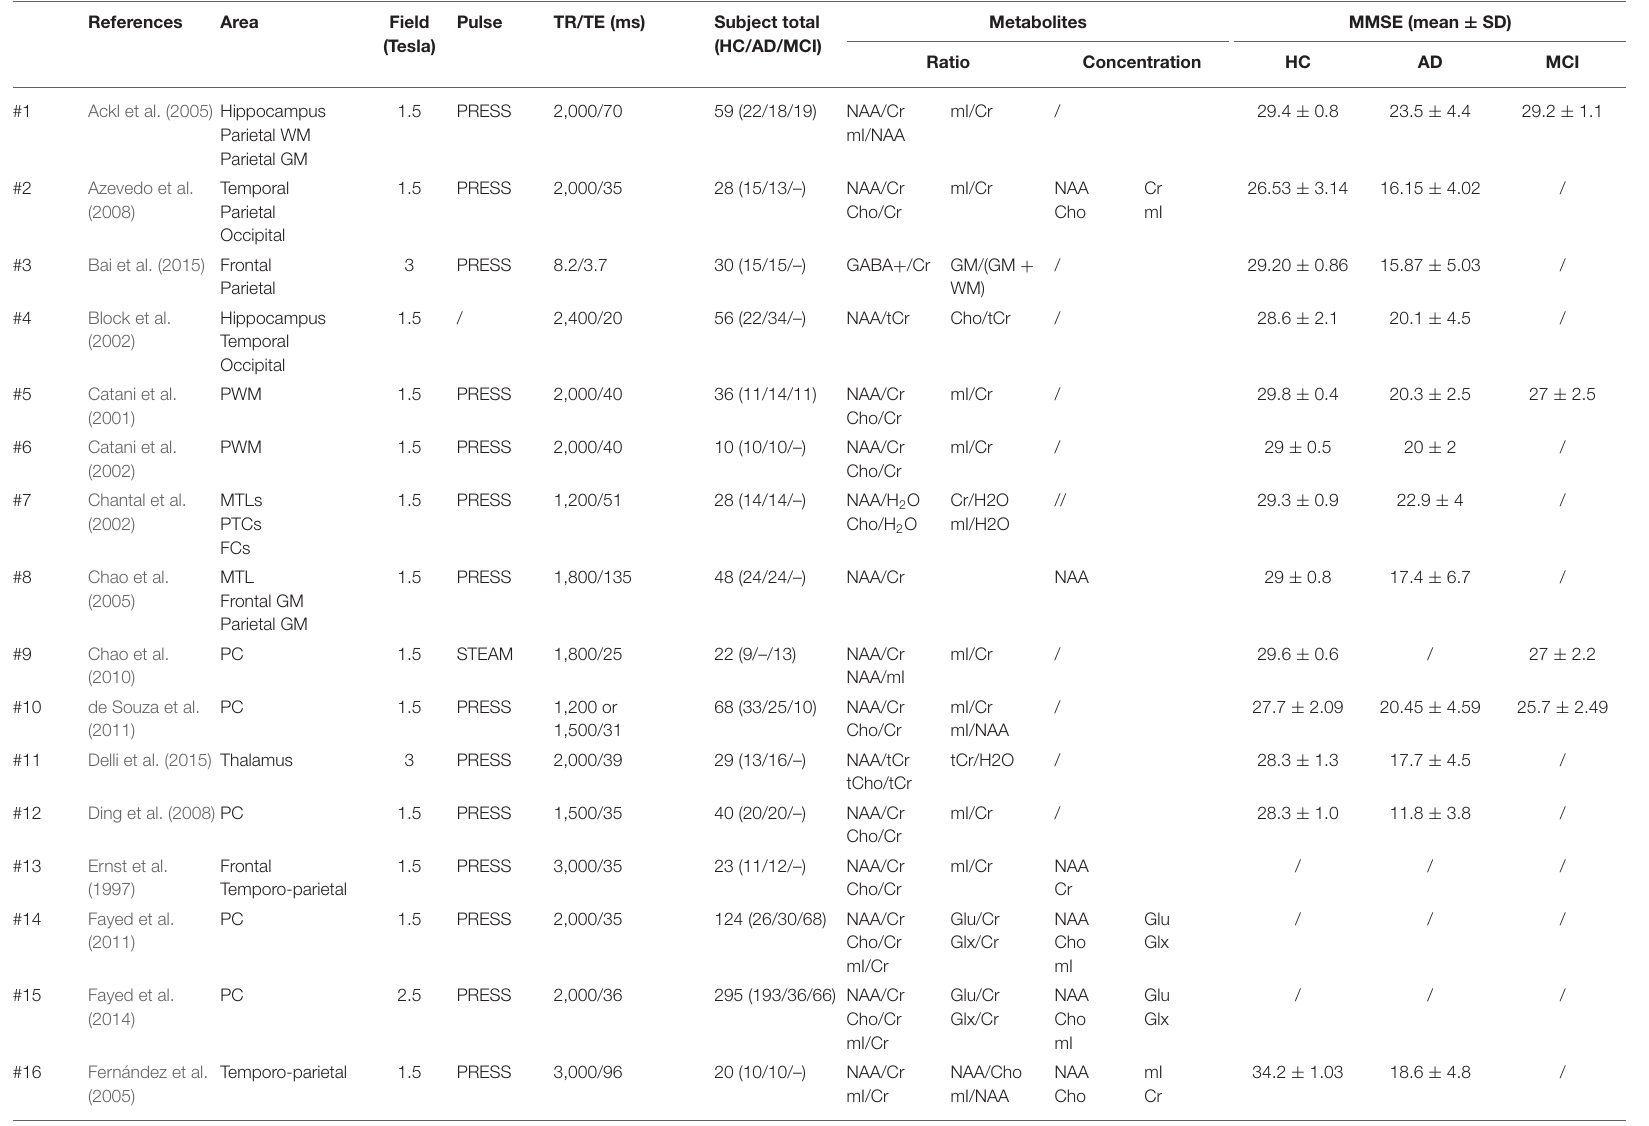
TABLE 1 | Characteristics of included studies for the